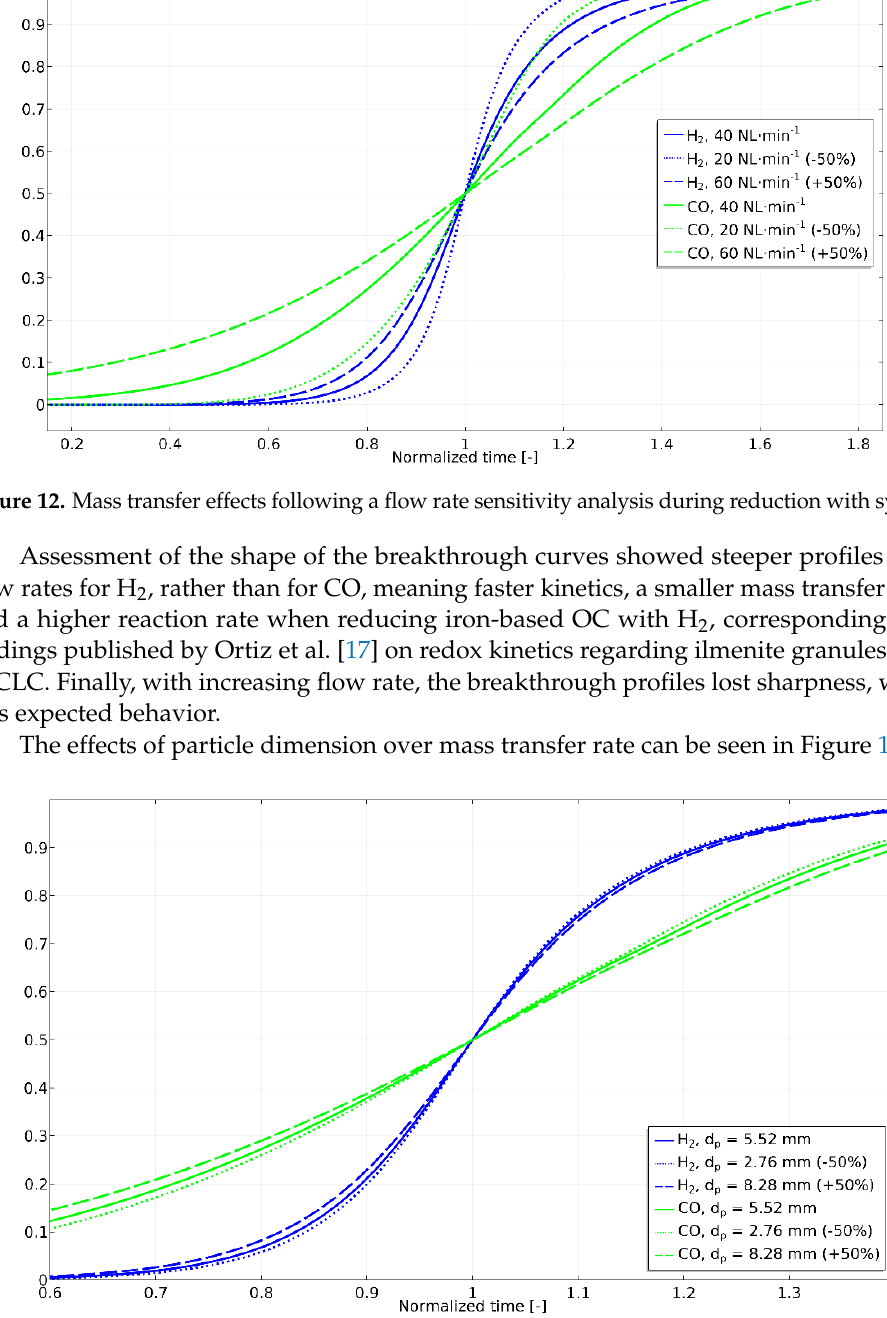
Figure 11. Model predicted breakthrough curves after iron-based OC reduction with syngas.